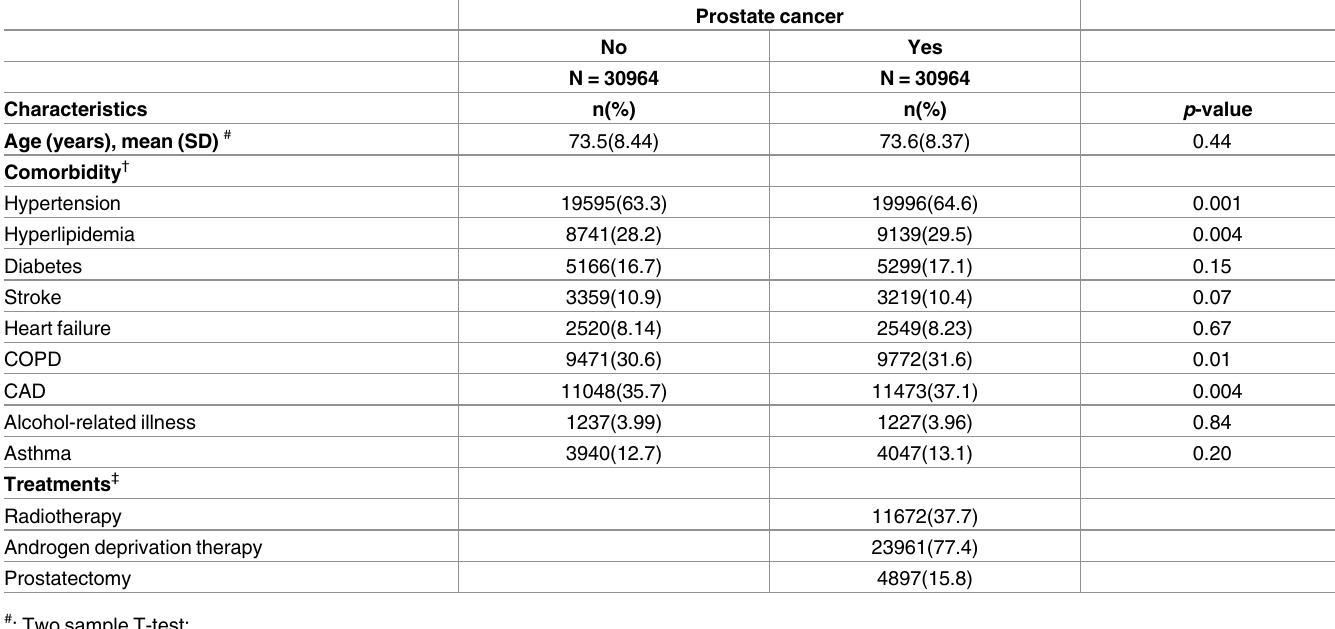
Table 1. Baseline characteristics in patients with and without prostate